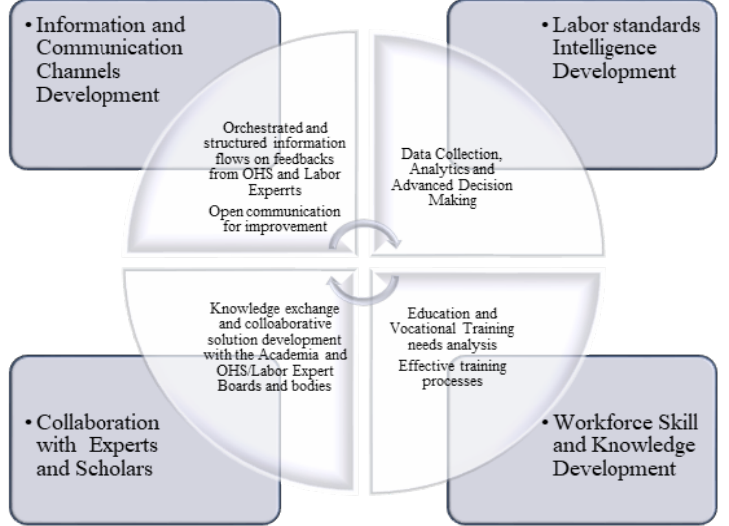
Figure 9. Recommended Strategic Agenda for the Policy Makers and Employers in the Construction